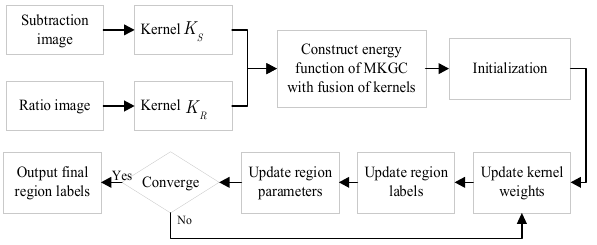
Figure 2. Iterative optimization of MKGC.